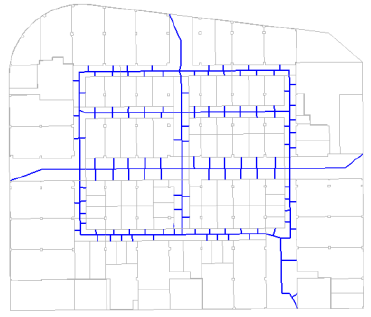
Figure 7 Route modelling for single floor